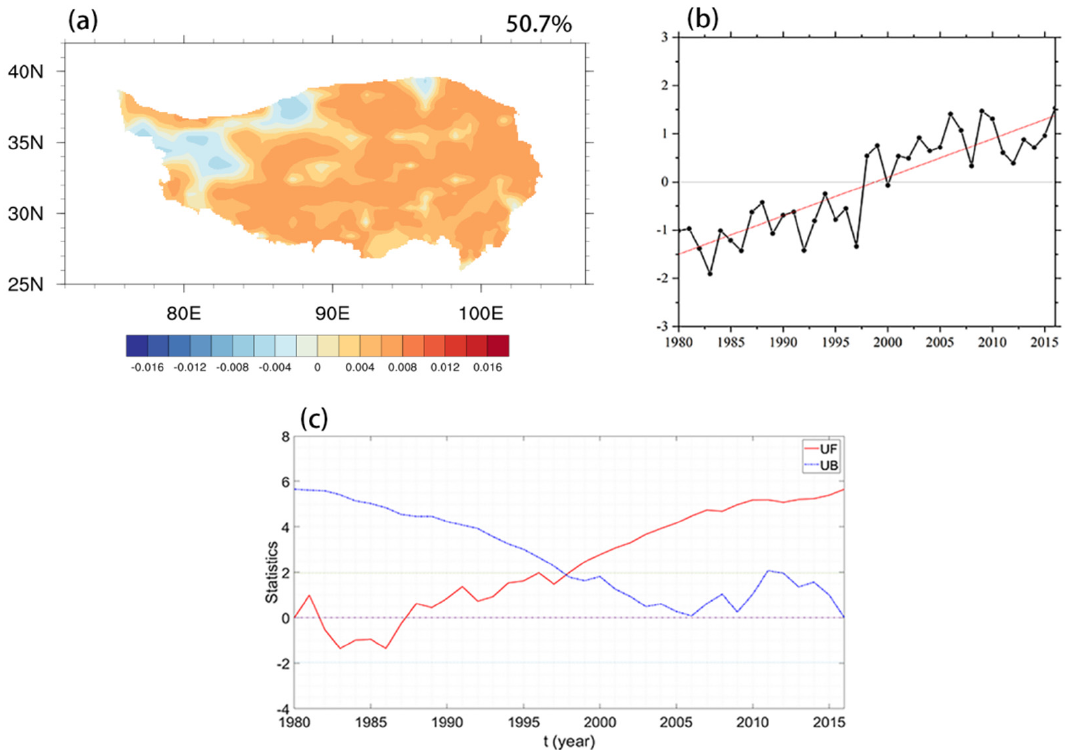
Figure 4. Temperature patterns on the TP from 1980 to 2016. ( a ) EOF1 spatial pattern. ( b ) Time coefficient. ( c ) Mann–Kendall trend test.